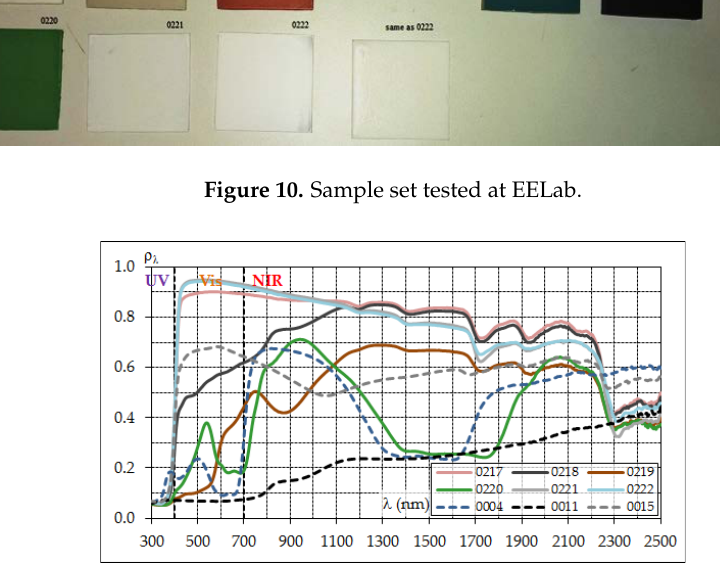
Figure 11. Measured reflectivity spectra. Table 2. Measured solar reflectance values.